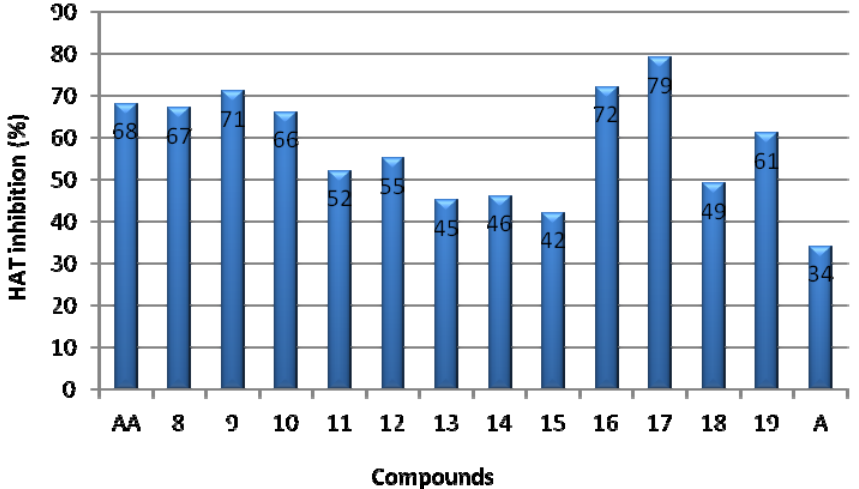
Figure 3. PCAF HAT inhibitory activity of 8 – 19 in 100 μ